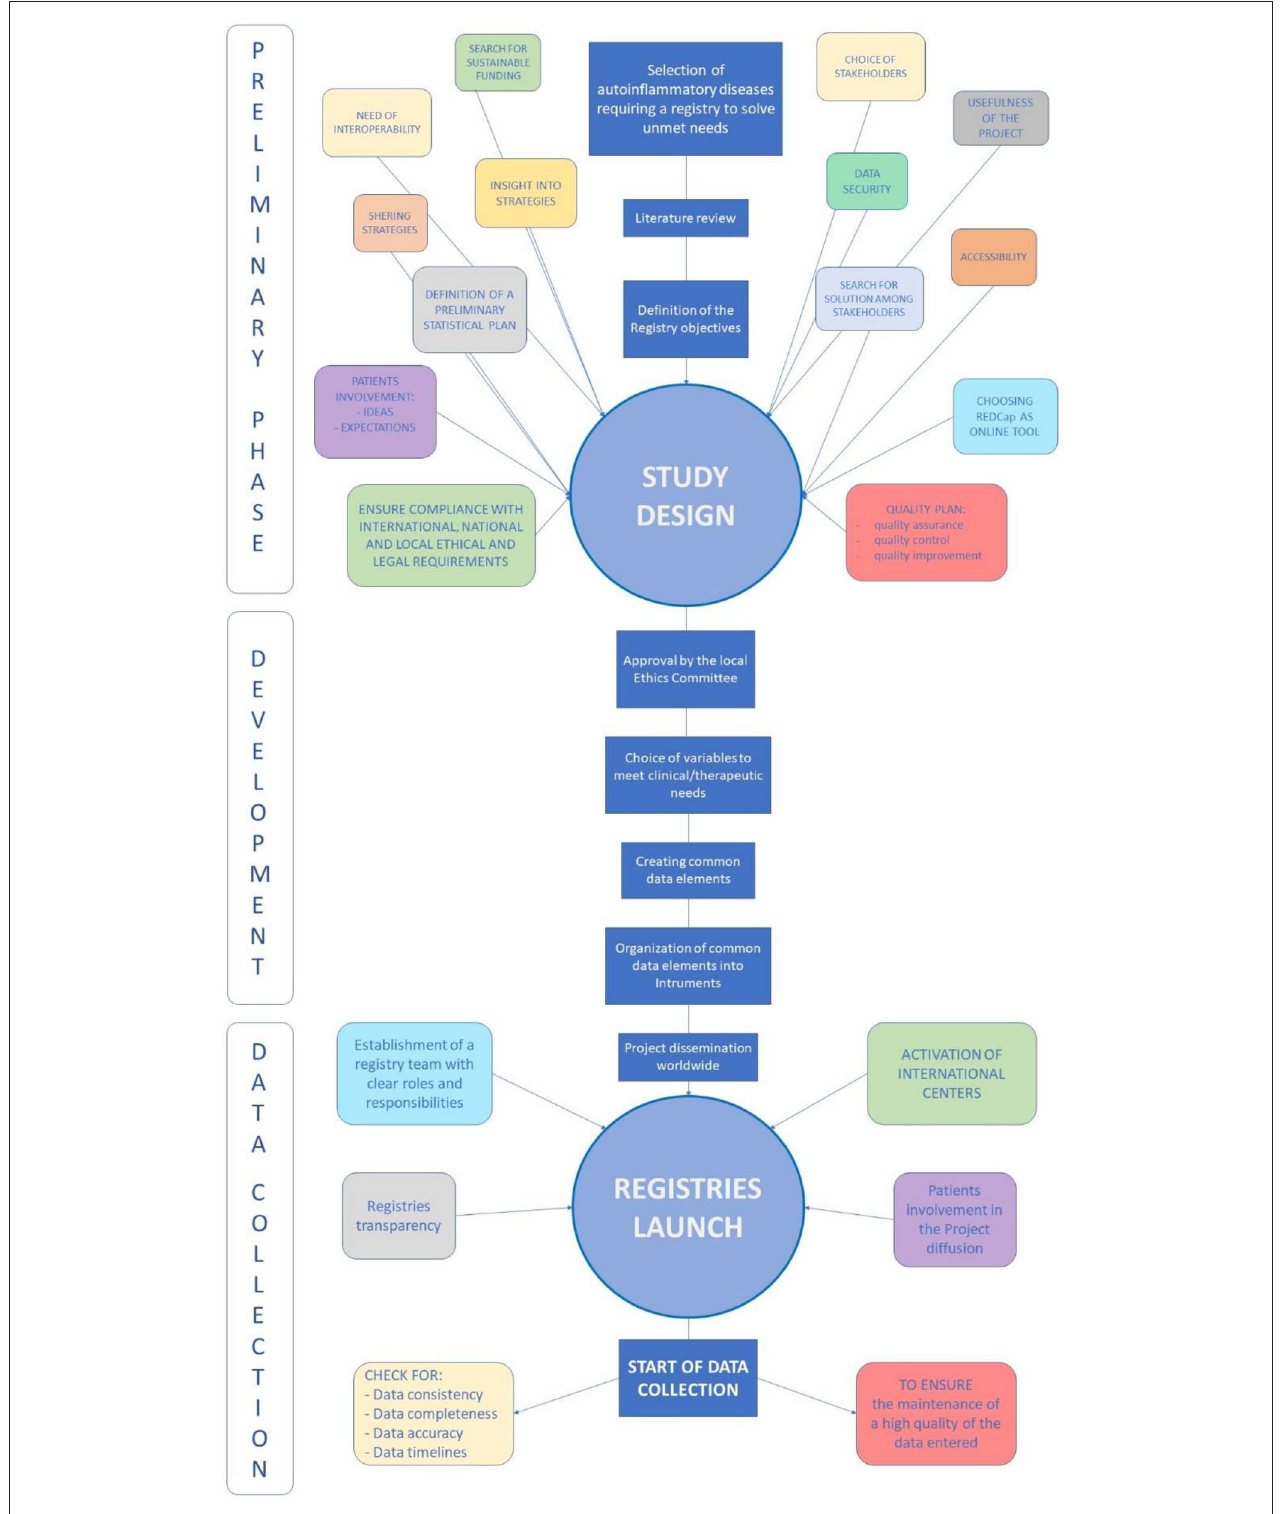
FIGURE 1 | Summary of the main phases corresponding to the creation of the Registry: the preliminary phase with all the elements required to carry out the project; the development phase during which common data elements and instruments of the Registry were realized; the data collection phase following the launch of the Registry accompanied by the efforts to maintain the high quality of data entered and of the Registry according to the new scientific acquisition.